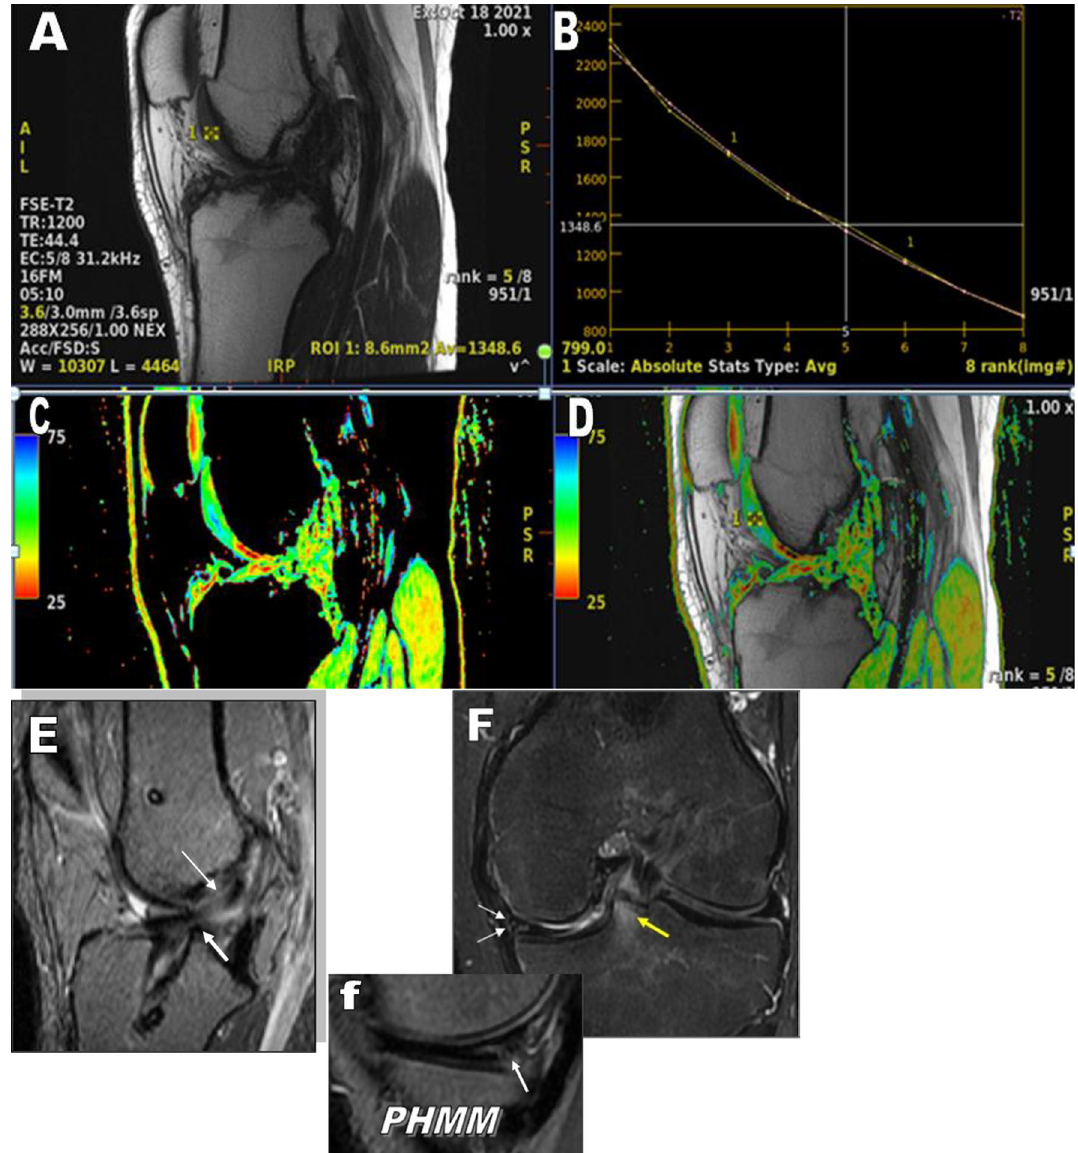
Fig. 9 A 34-year-old male patient underwent ACL reconstruction and medial meniscectomy 8 years ago, the patient complained of knee pain and swelling. In assessment of the MRI knee, the conventional images show ACL graft buckling and thickening, medial meniscal tear and mild knee joint effusion. Sagittal T2 image ( A ) at lateral femoral condyle level shows thickening of the articular cartilage upon the lateral femoral condyle anterior segment. On the post processing T2 mapping image: ( C , D ) The colour image along the articular cartilage of the lateral femoral condyle anterior segment revealed internal areas of blue colour (Yellow ROI) within the deep part with increased T2 value (as demonstrated within the curve image ( B )) that corresponds to articular cartilage degeneration. According to the international cartilage Repair Society (ICRS) grading system, this corresponds to grade I cartilage degeneration. Sagittal STIR image ( E ) at the intercondylar notch level shows relative anterior position and vertical orientation of the tibial tunnel is noted. Mild thickening and buckling of the anterior cruciate ligament graft with intrinsic high signals, yet no evidence of fiber disruption. Findings suggestive of ACL graft roof impingement (White arrows). Coronal ( F ) and focused sagittal STIR image upon the medial meniscus level(f), the body and posterior horn of medial meniscus show intra-substance linear band of bright signals reaching the menisco-capsular attachment and abutting the inferior articular surface, corresponds to meniscal tear (White arrows). Note the patchy bone marrow edema signals surrounding the tibial tunnel, displaying high STIR signals (Yellow